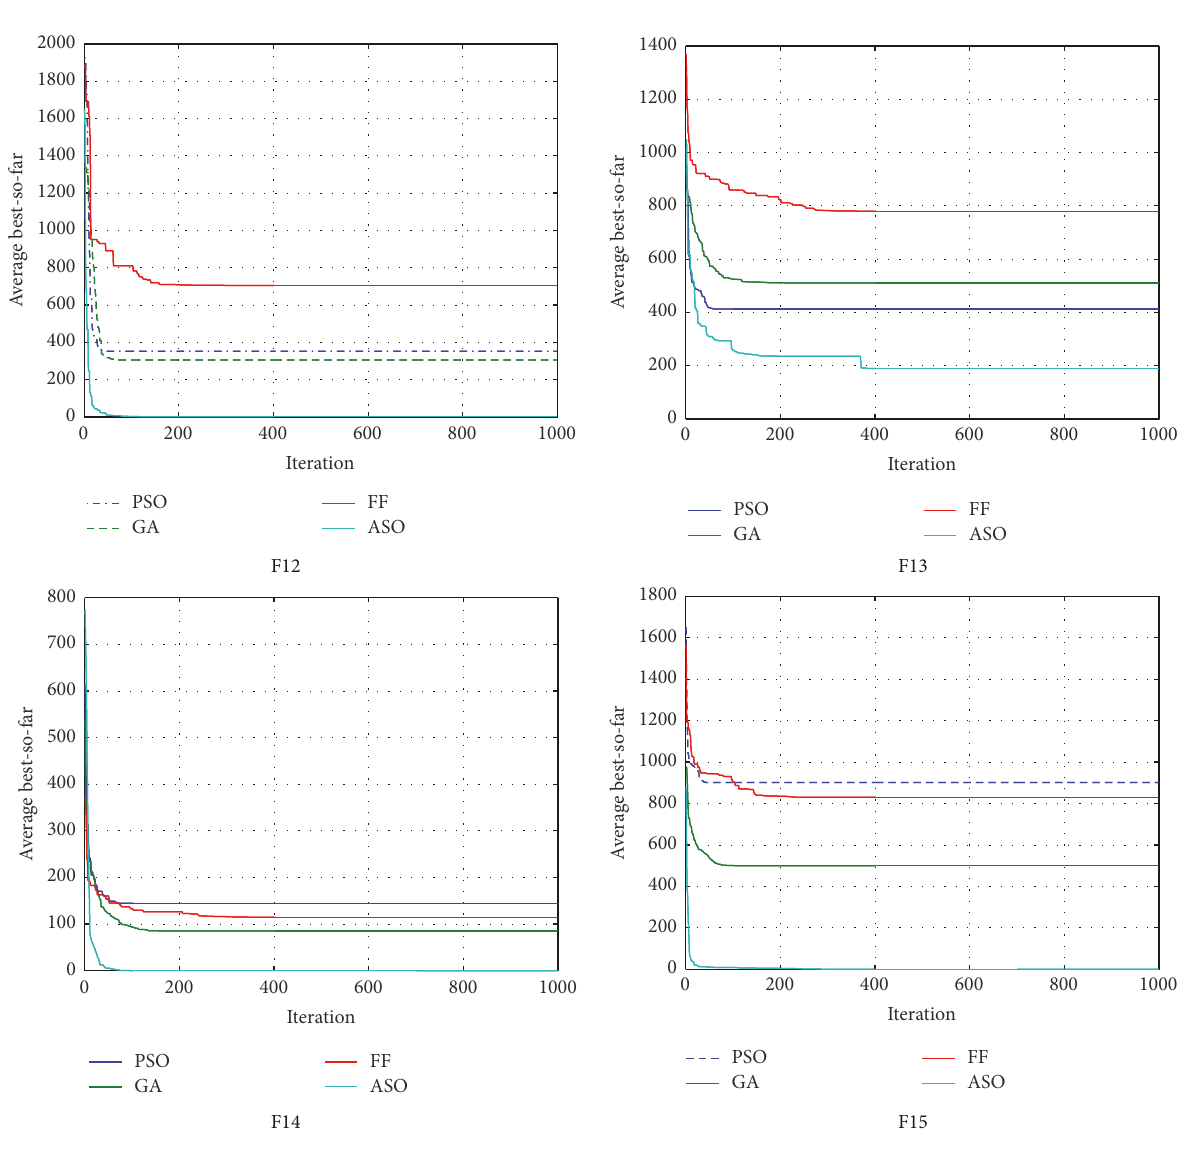
Figure 5: Comparison based on convergence